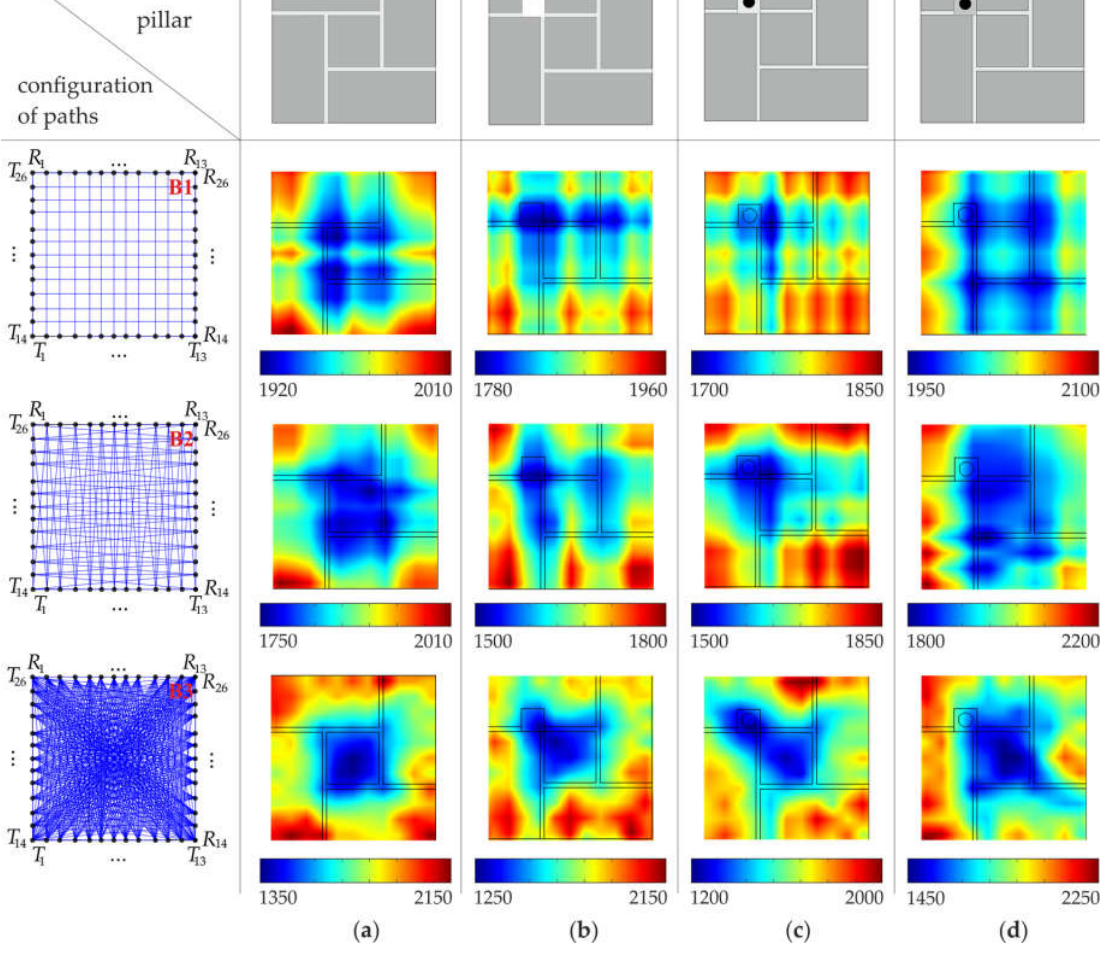
Figure 10. Tomographic velocity images (values in (m/s)), with a division into 169 pixels (configuration #B), obtained from experimental signals: ( a ) intact pillar; ( b ) pillar with the square hole; ( c ) pillar with the steel bar grouted by means of gypsum mortar; ( d ) pillar with the steel bar grouted by means of cement mortar.